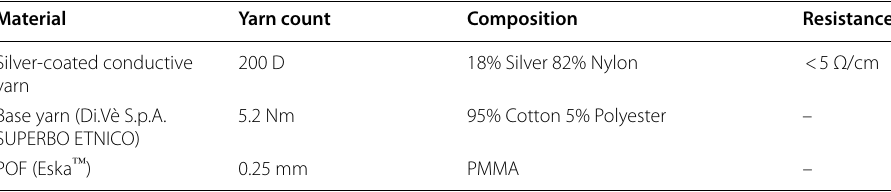
Notes: POF polymeric optical fibre, PMMA polymethyl methacrylate